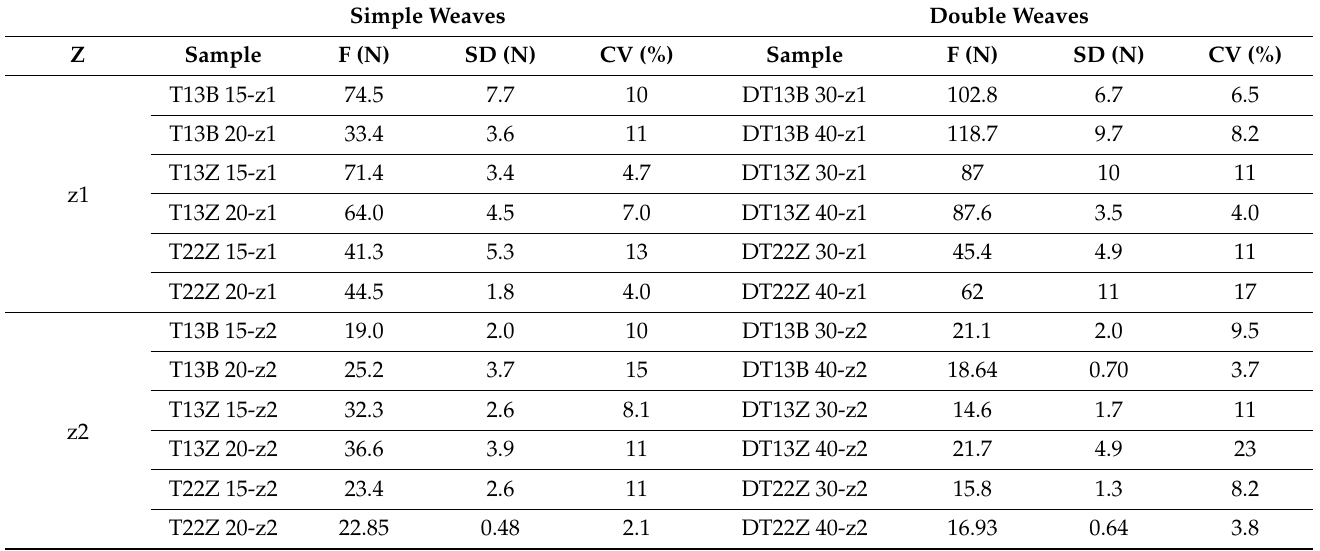
Table 5. Average maximum adhesion force (F), standard deviation (SD), and coefficient of variation (CV) for all samples of fabrics woven with simple and double weaves at different weave structures, weft densities, and